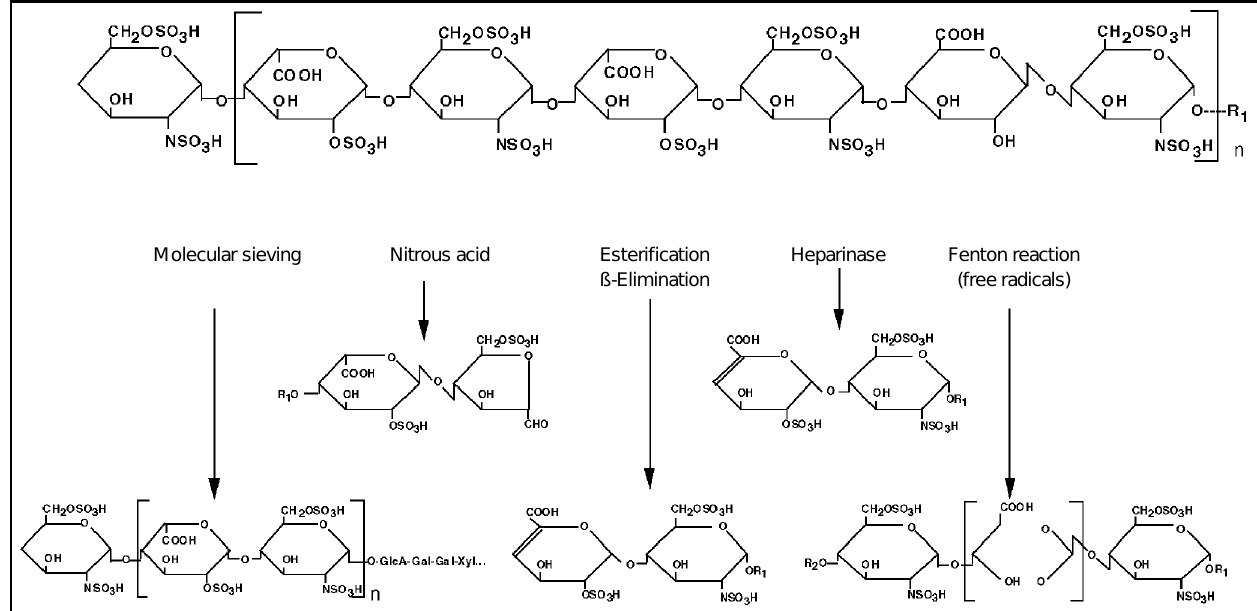
Figure 3. Methods of preparing low molecular weight heparins. Molecular sieving, gel filtration on Sephadex G-50 (29); nitrous acid, limited nitrous acid reaction (30); esterification and ß-elimination, benzylation and ß-elimination by a method developed by Aventis; heparinase, limited degradation with heparinase from Flavobacterium heparinum (2); Fenton reaction, oxidation with free radicals generated from H 2 O 2 and Cu 2+